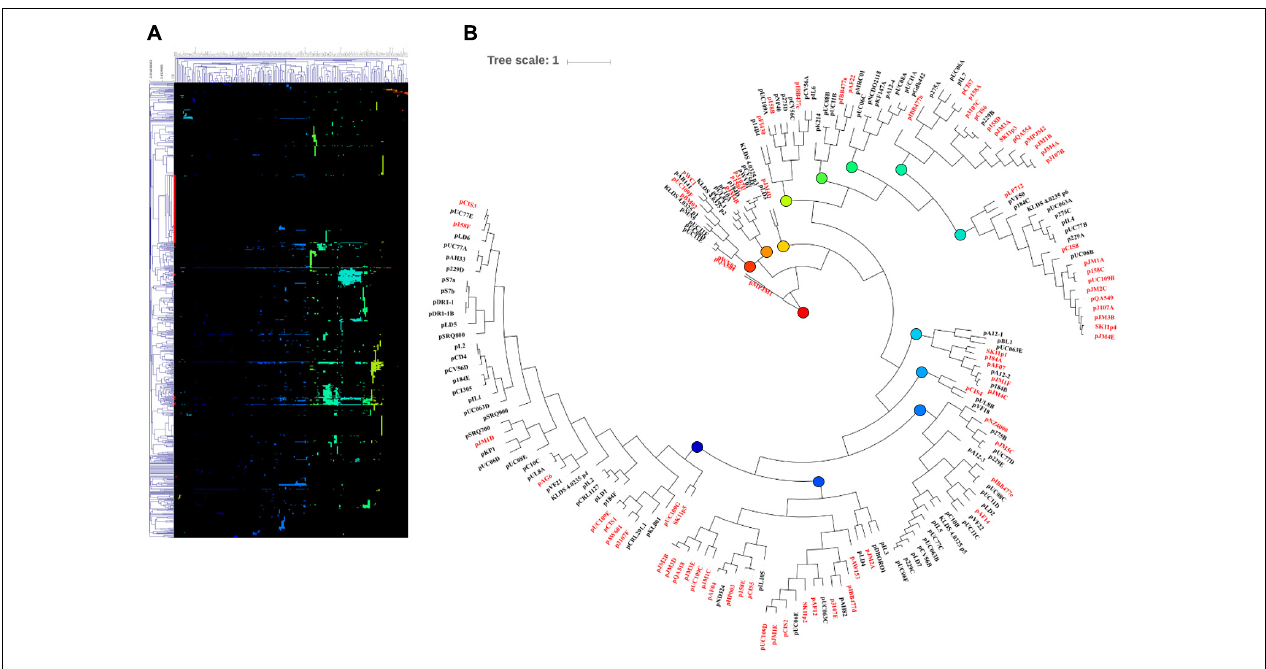
FIGURE 2 | HCL analysis of the lactococcal plasmidome. Hierarchical clustering analysis (A) representing the presence/absence of gene families from 190 lactococcal plasmids. Absence of gene family members is indicated in black and presence of gene family members is indicated in color. (B) Circular tree representation of panel A displaying HCL plasmid groupings. Plasmids from subsp. cremoris strains are labeled in red while plasmids from subsp. Lactis strains are labeled in black. Colored nodes correspond to the presence of genes (colors) in HCL matrix (panel A